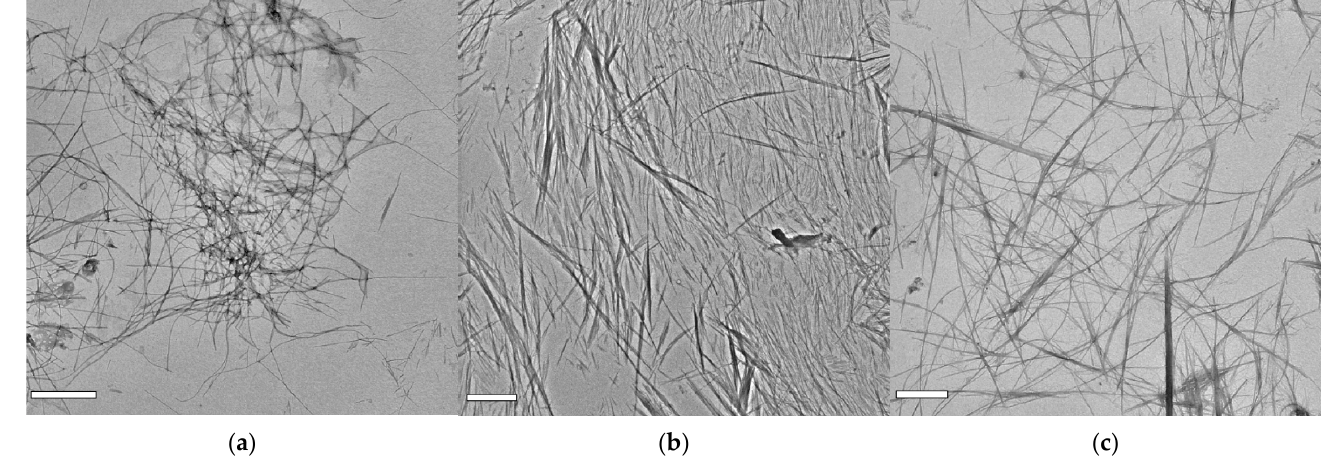
Figure 4. TEM images of diluted samples of hydrogel H1 ( a ), H2 ( b ), and H3 ( c ). The scale bar represents 1 μ m ( a , c ) and 2 μ m ( b ).